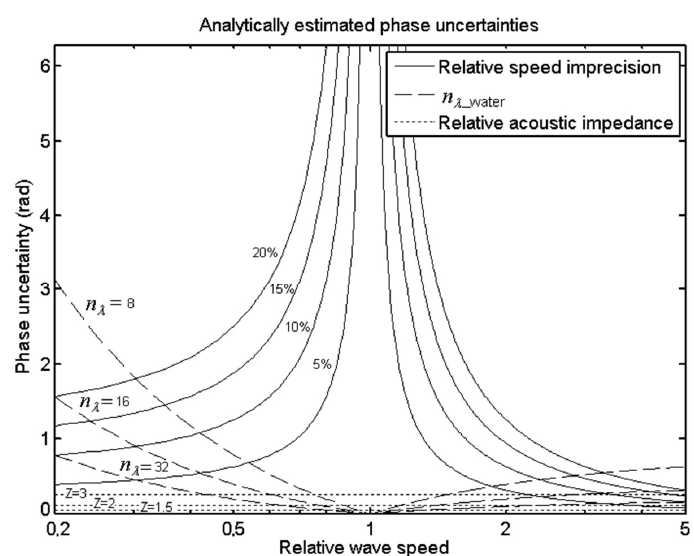
Figure 3. Analytical estimation of the uncertainties in the phase recreated by the 3D lens at the holographic surface associated with the discretization of the domain in voxels per water wavelength, n λ_water , (dashed), with the acoustic impedance of the lens when the definition of the thickness is approached by linear interpolation (dotted) and with possible differences between simulated and real values of the p-wave speed of the lens (continuous).